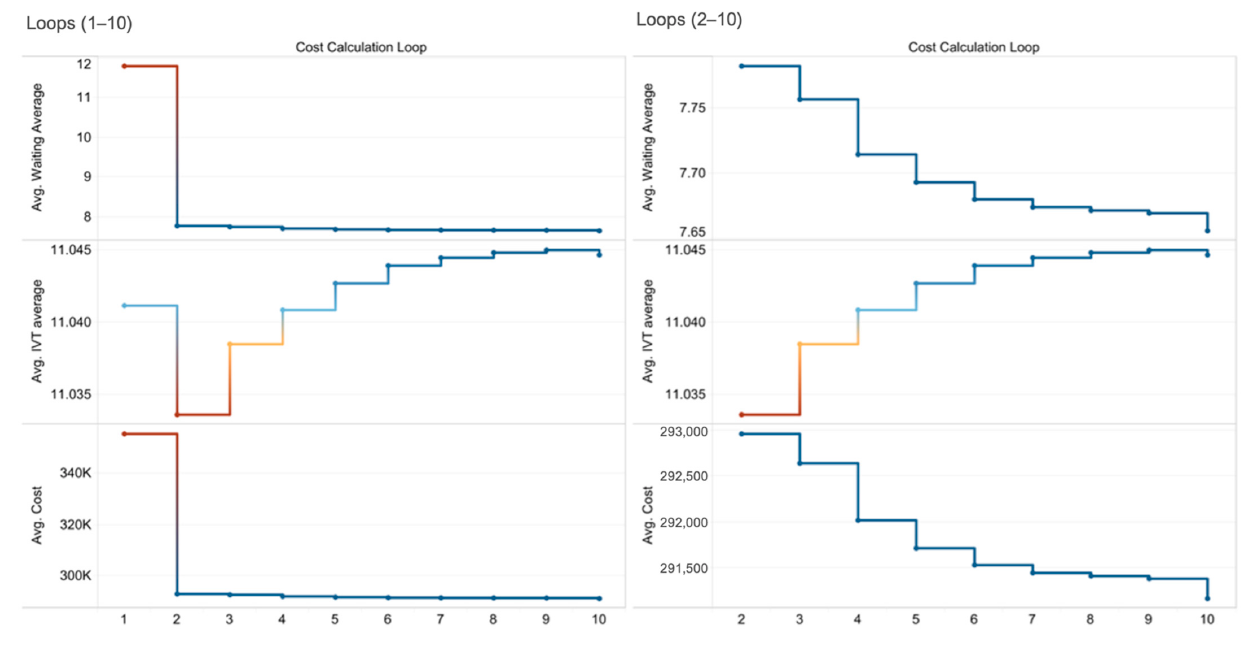
Figure 2. Differences observed after each calculation loop.